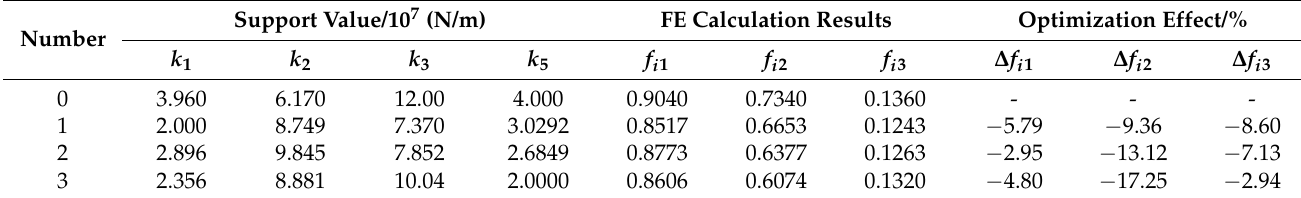
Table 10. Optimization